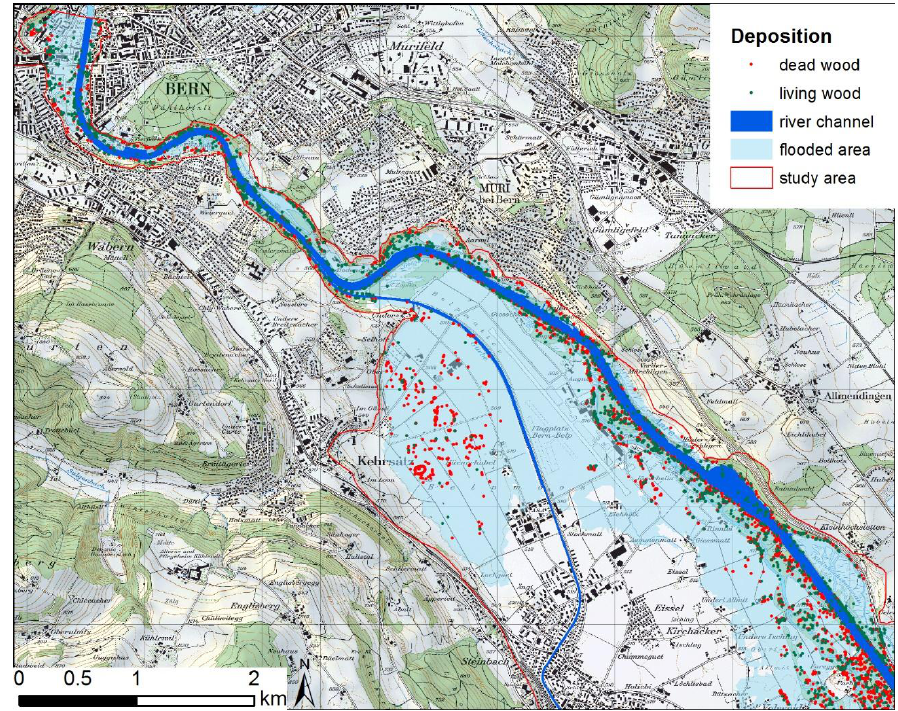
Figure 7. Extract of the map of the deposition areas in the Aare River floodplain upstream of Bern. The dots show the locations of the wood logs at the end of the simulation. Background map: Federal Office of Topography SWISSTOPO.